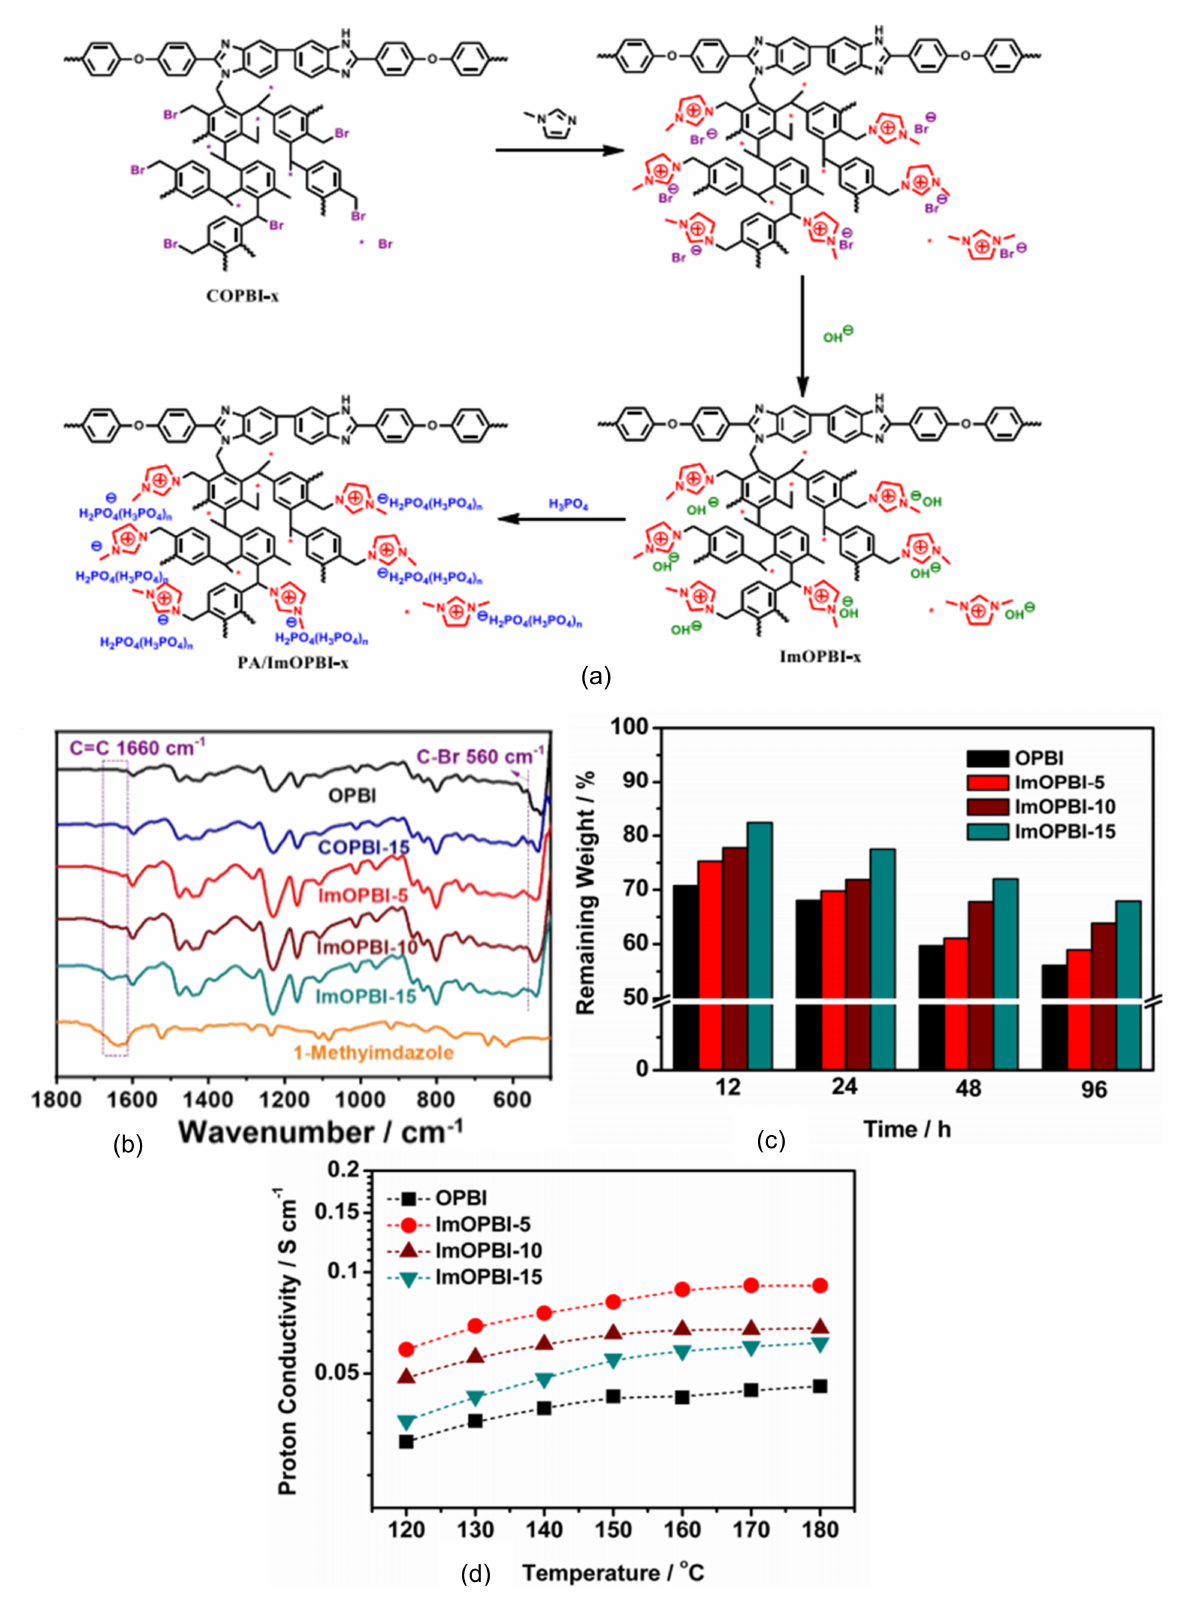
Figure 12. ( a ) Preparation of hyperbranched cross-linker ImOPBI-x, ( b ) FT-IR results, ( c ) phosphoric acid retention ability and ( d ) proton conductivity